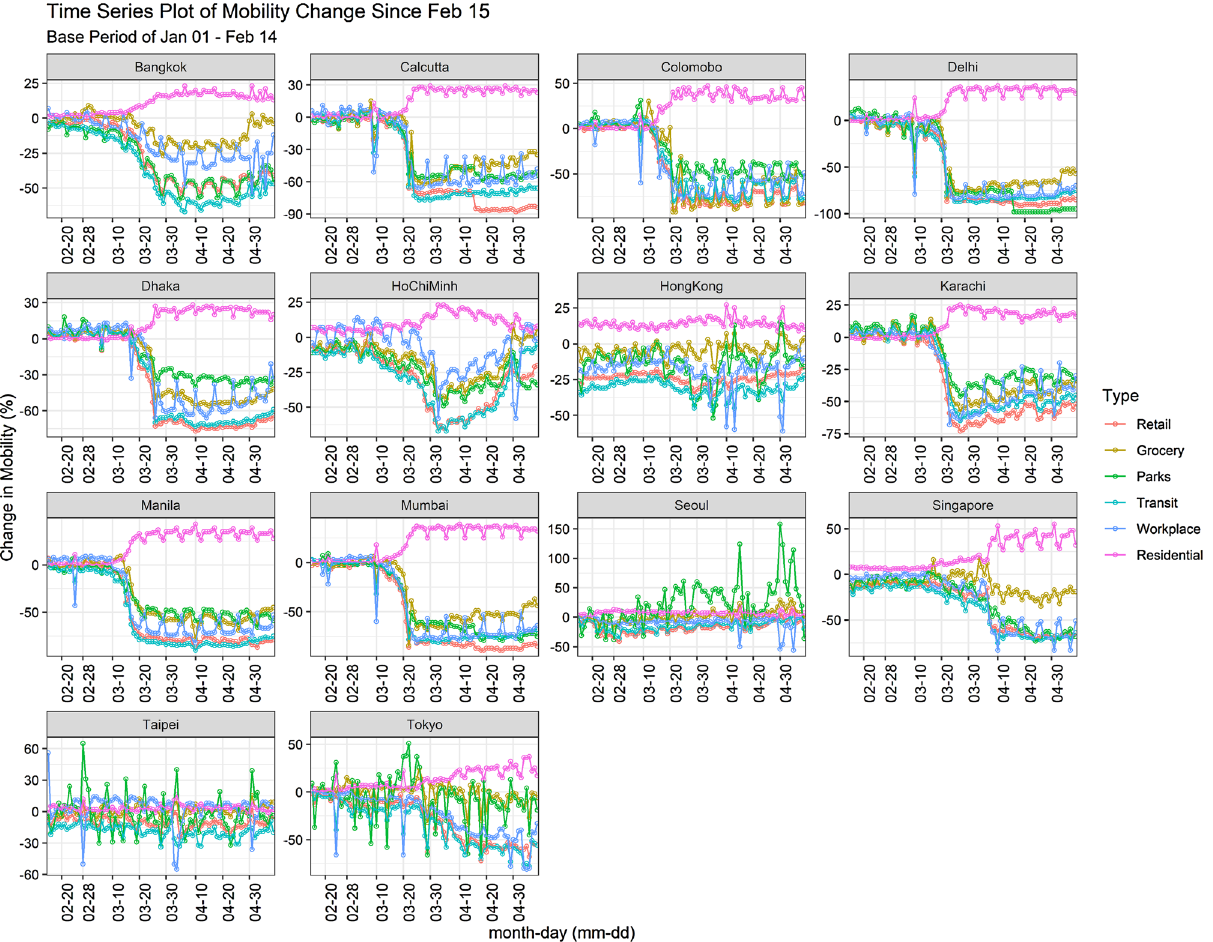
Figure 5. Patterns of changes in mobility in different cities due to lockdown implementation. The anomalies are computed with respect to base period from 1st January to 14th February spatially averaged over the hot spot region of the corresponding cities for time series assessment. Therefore, an underlying limitation of the datasets and the analysis could be the coarse spatial resolution of the imagery and spatial averaging which must be considered while assessing the pollutant concentration at local scale. We used the monthly mean image of NO 2 in 2019 to demarcate the hotspot areas by drawing a confound- ing rectangle around the high concertation pixels (Fig. S1). The environmental data analysis consists of two components—i) time series analysis from January 01 to May 22 for the year 2019 and 2021, and ii) periodic changes in the five different periods and their significance difference with average values during January 2019. The statistical significance between the periods was tested using the non-parametric Wilcoxon Rank test. The temporal patterns were also fitted using a Local Polynomial Regression Fitting (loess) algorithm to show the overall changes over time. Considering the first outbreak of the pandemic and implementation of lockdown strategies among the cities, the analysis timeframe was divided into five consecutive periods—P1 (January 01 to January 22), P2 (January 23 to February 22), P3 (February 23 to March 22), P4 (March 23 to April 22) and